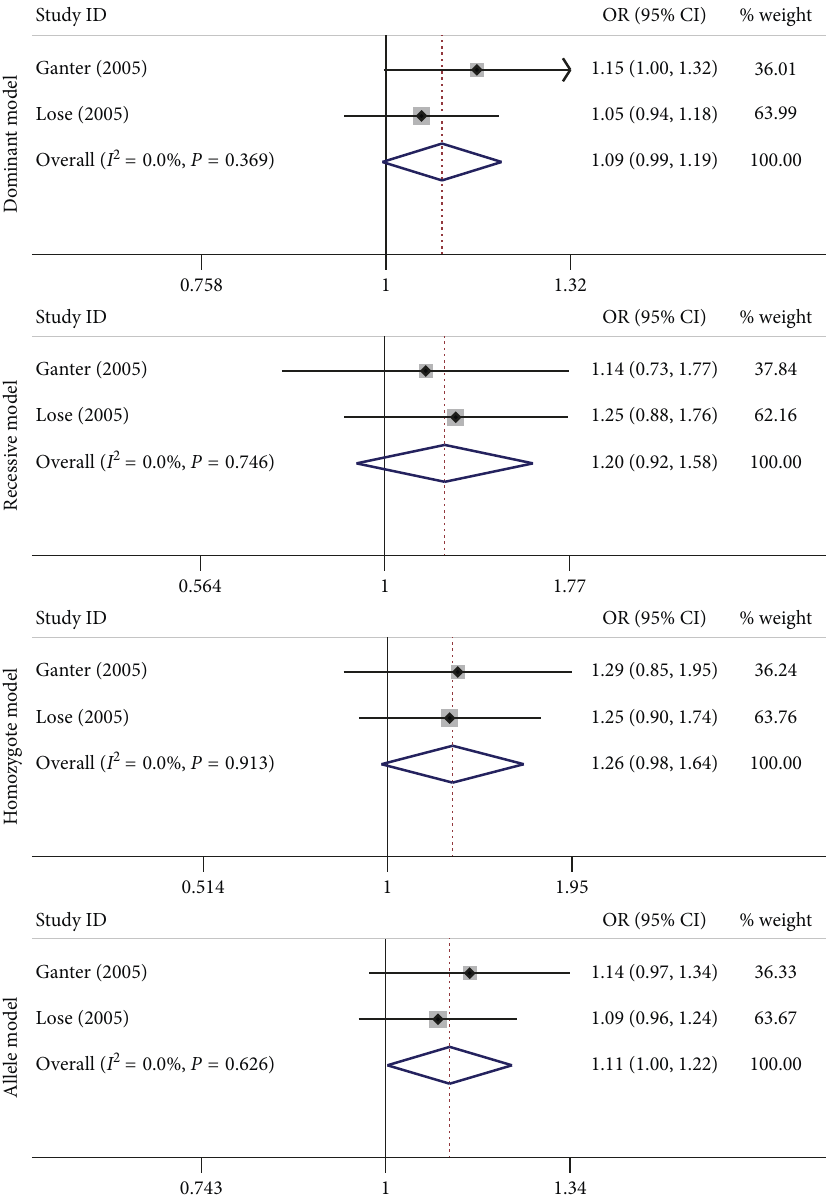
Figure 3: Forest plots of the association between the MMP-9 Gln279Arg, rs17576 polymorphism and risk of asthma in the dominant model, recessive model, homozygote model, and allele model